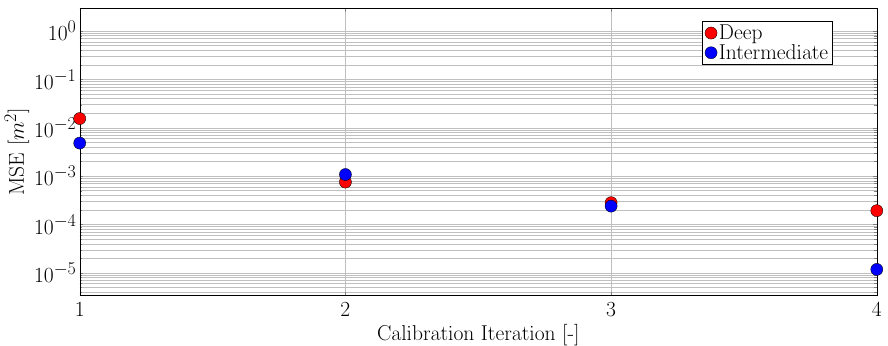
Figure 14. Error in wave amplitude versus number of calibration